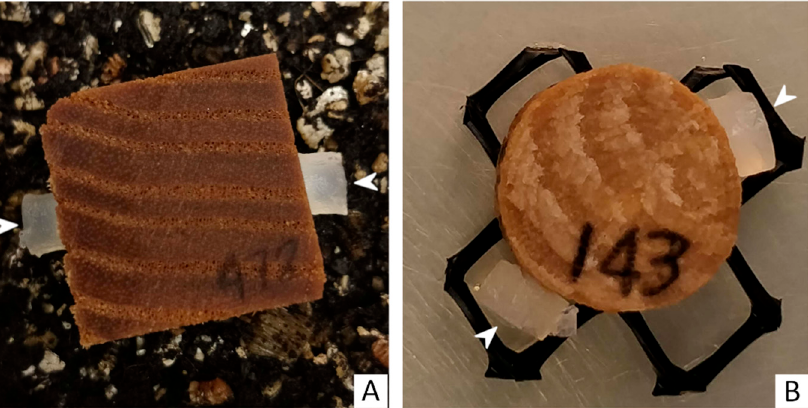
Figure 1. Ash blocks and sapwood discs were used in two studies with soil or agar microcosms. ( A ) Inoculated ash block in soil microcosm; ( B ) inoculated ash sapwood disc on plastic mesh in agar microcosm. White arrowheads indicate agar plugs.